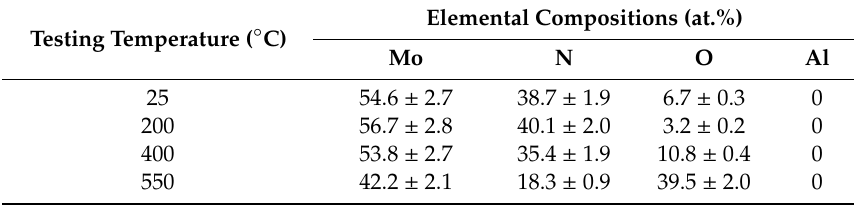
Table 1. Elemental compositions on the wear track at various testing temperatures. Testing Temperature ( ◦